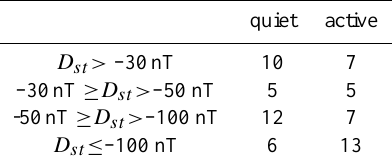
Table 2. Averages of V max , D st , Bz min and V Bs max for solar min quiet and active periods. Bz min V max V Bs max D st (nT) (km/s) (nT) active period a